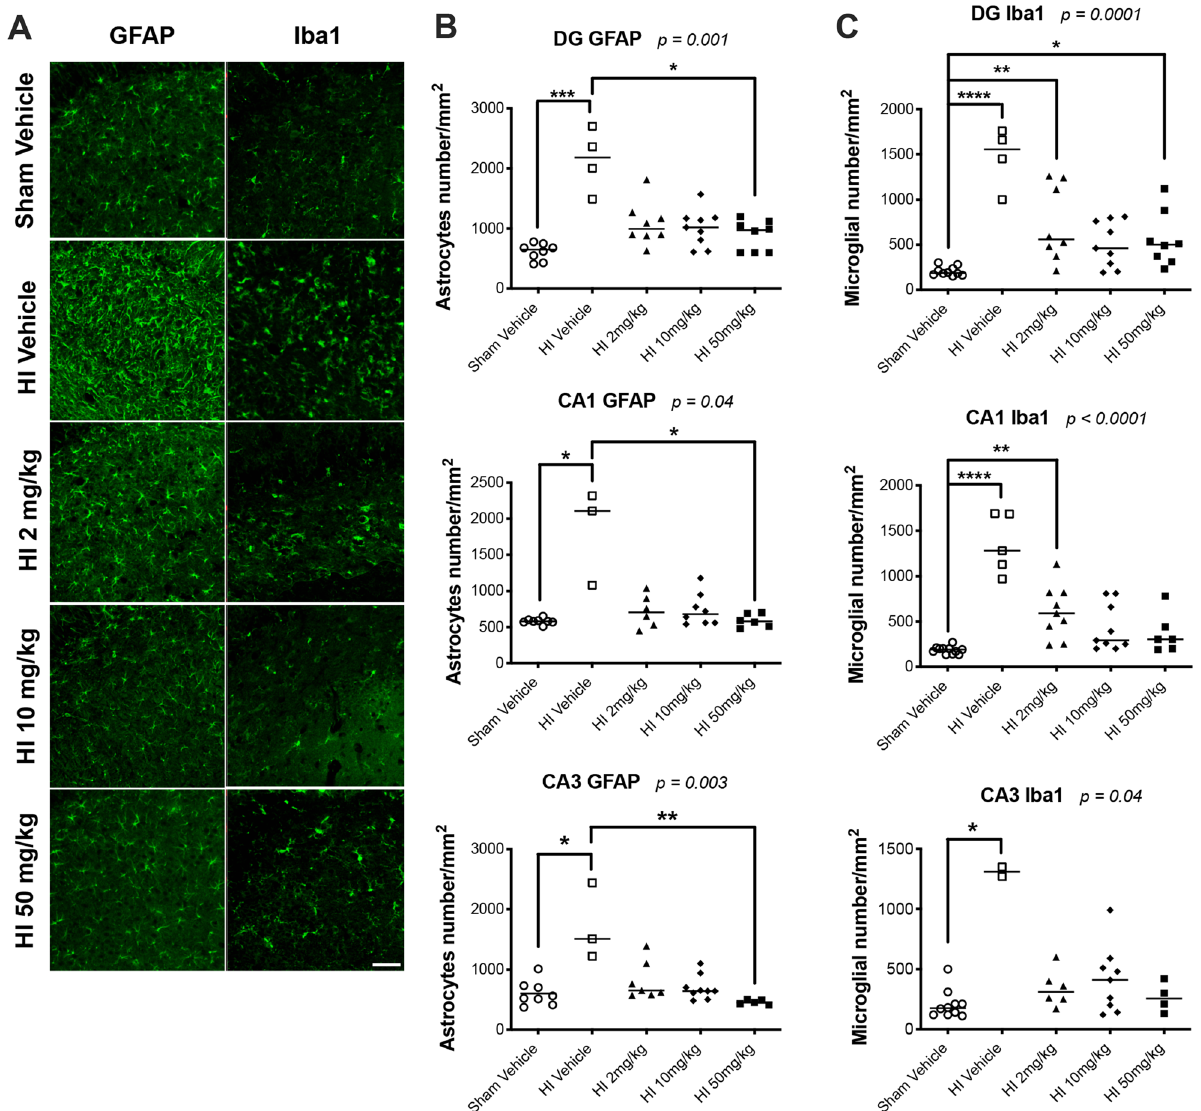
Figure 5. Immunostaining for astrocytes and microglia in sham and HI rat pups treated with vehicle or sildenafil. Cells were counted in three regions of the hippocampus: i.e., dentate gyrus, CA1, and CA3 regions of the ipsilateral hippocampus. ( A ) Representative immunofluorescent micrographs of astrocytes labeled with GFAP and activated microglia labeled with Iba1 in the ipsilateral dentate gyrus. ( B ) Astrocytes labeled with GFAP, and ( C ) activated microglial cells labeled with Iba1 (median with individual data points representation). Significance: p value from Kruskal–Wallis test, with Dunn’s post-hoc comparison tests: * p < 0.05, ** p < 0.01, *** p < 0.001, **** p < 0.0001. Number of animals: n = 8 sham vehicle, 4 HI vehicle, 8 HI 2 mg/kg, 9 HI 10 mg/kg and 8 HI 50 treated with vehicle. In addition, the treatment with sildenafil reduced microgliosis. In the DG, the medium-dose of sildenafil reduced the active microgliosis to levels not significantly different than sham rats; the low- and high- doses of sildenafil also reduced the microgliosis, but the number of microglia cells remained significantly higher (respectively, p < 0.01; and p < 0.05), compared to sham rats (Fig. 5A,C). In the CA1 region, both the medium- and high-doses of sildenafil reduced the active microgliosis to levels not different than sham rats. With respect to the low-dose of sildenafil, the number of microglia cells were reduced but remained significantly higher ( p < 0.01) than the levels we observed in the sham rats. In the CA3 region, all the doses of sildenafil reduced the active microgliosis to levels not different than sham rats. HI decreased the activity of the Pl3kAKT/mTOR pathway in the hippocampus, and sildena- fil avoided this effect. Two days after HI (P12), the p-AKT level decreased significantly ( p < 0.05), com- pared to sham rats (Fig. 6A), which was associated with a significant decrease in the levels of mTORC1 (serine 2448) ( p < 0.05) (Fig. 6B) and mTORC2 (serine 2481) ( p < 0.01) (Fig. 6C). The levels of mTORC1 (serine 2448)